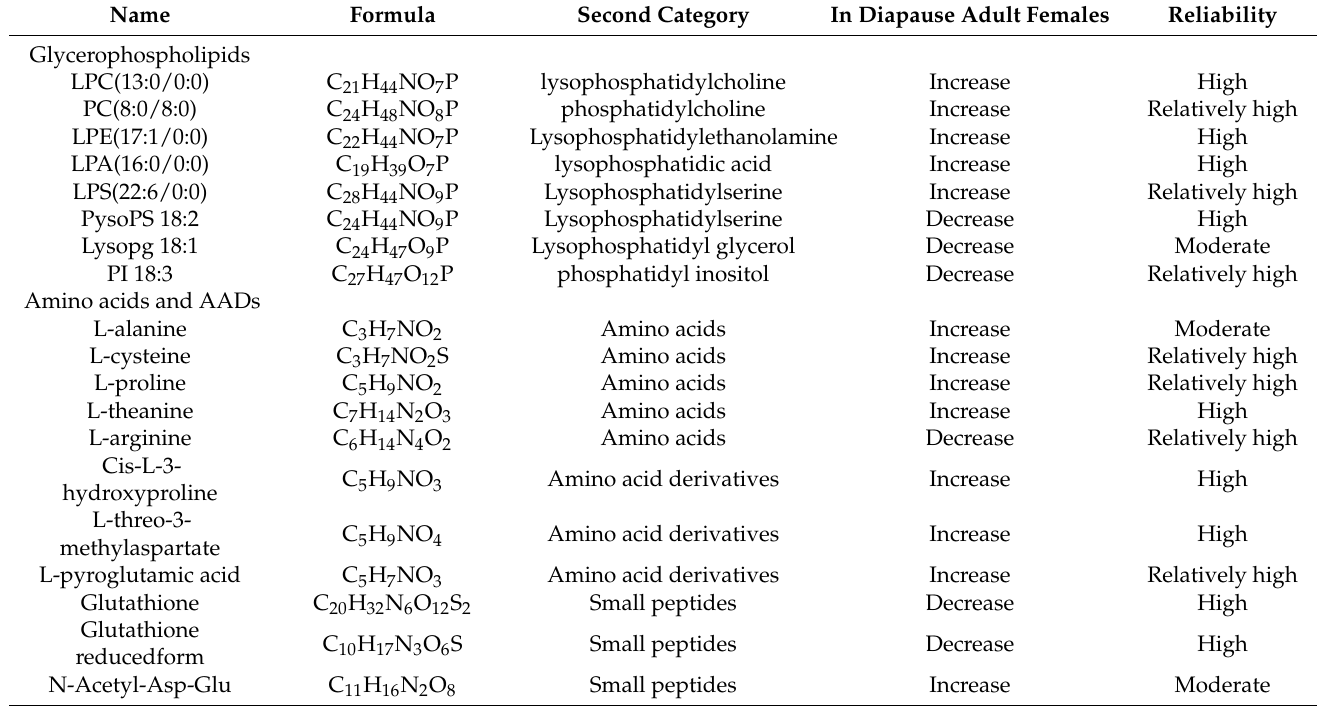
Table 3. Potential biomarkers (glycerophospholipids and amino acids or AADs) for entering the diapause maintenance stage of